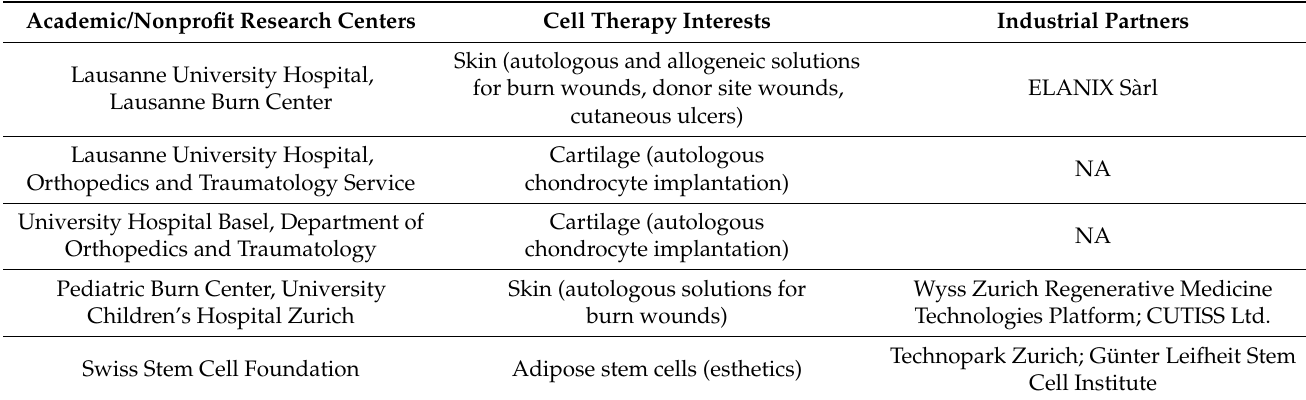
Table 3. Overview of notable public and nonprofit actors implicated in cell therapy development and clinical implementation in Switzerland, along with main cell therapy interests and identified industrial development partners. NA, not